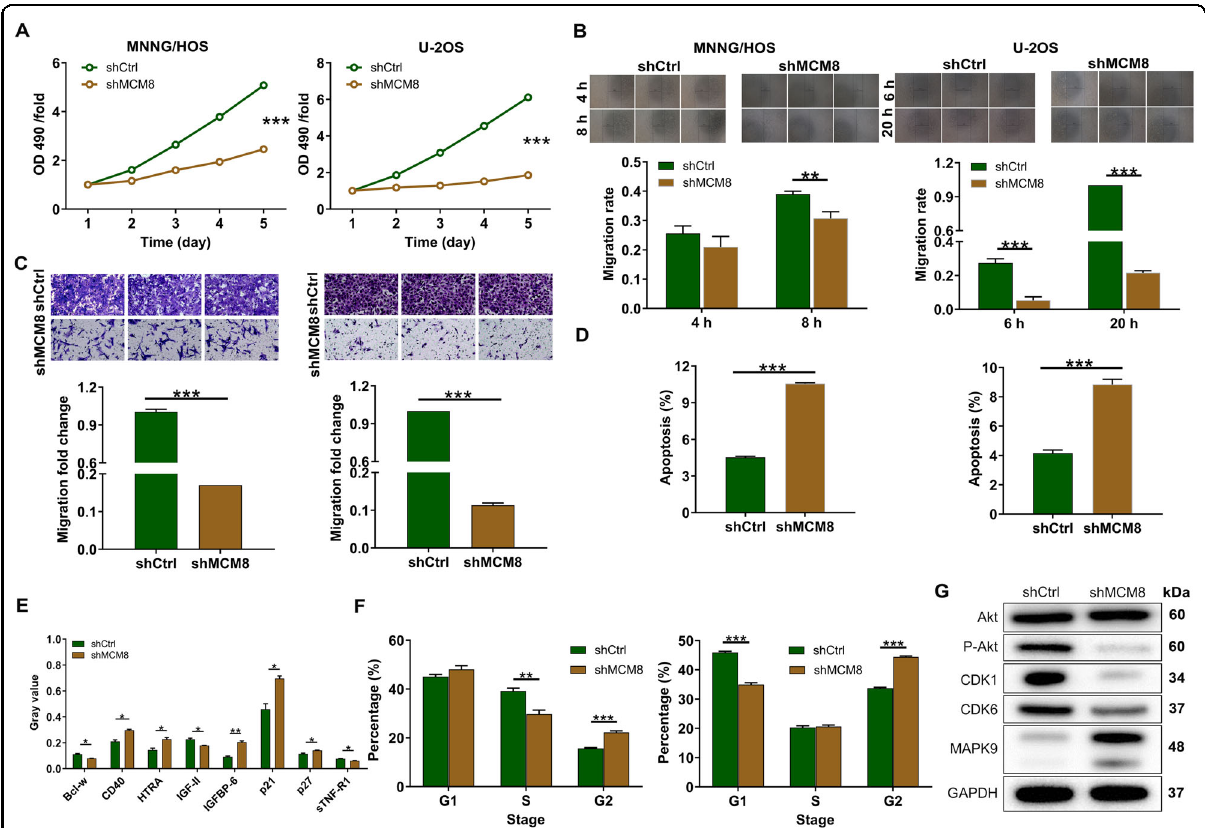
Fig. 2 MCM8 knockdown inhibited osteosarcoma development in vitro. A The cell proliferation rate was evaluated in osteosarcoma cell lines after transfection by MTT assay. B The migration rate of cells was detected in osteosarcoma cell lines after transfection by wound-healing assay. C The migration rate of cells was detected in osteosarcoma cell lines after transfection by transwell assay. Magni fi cation times: ×200. D The effects of MCM8 knockdown on cell apoptosis were examined by fl ow cytometry. E The expression levels of apoptosis-related proteins were analyzed in osteosarcoma cells with shMCM8. F The effects of MCM8 knockdown on cell cycle were determined by fl ow cytometry. Results were presented as mean ± SD. G The expression of Akt, P-Akt, CDK1, MAPK9, and CDK6 was detected by western blot in MNNG/HOS cells of shCtrl and shMCM8 groups. * P < 0.05, ** P < 0.01, *** P <